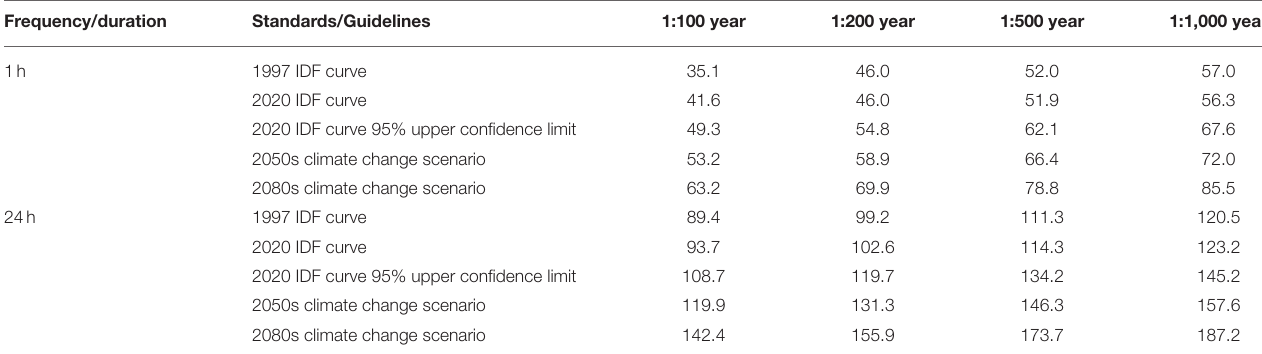
TABLE 1 | Rainfall depths (mm) for design storm events in Calgary (City of Calgary, 2011; GHD,